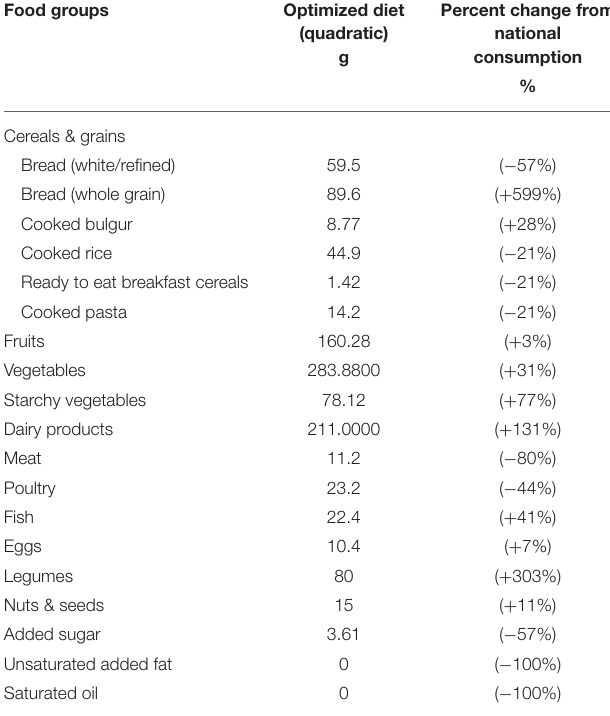
TABLE 5 | Results of the optimization calculations, with the percent change from national